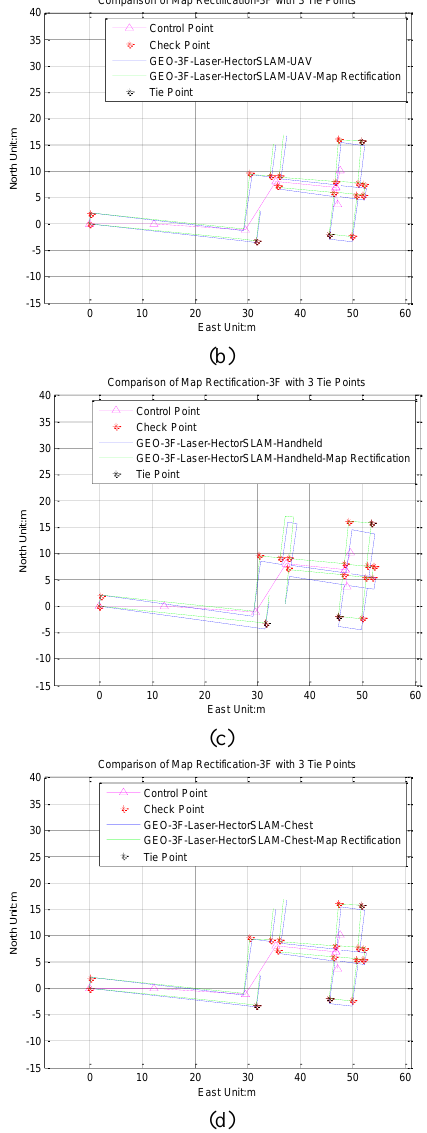
Comparison of Map Rectification-3F with 3 Tie Points Control Point Figure 8. The generated map using different platforms after map Check Point rectification. (a) shows the map using robot; (b) shows the map GEO-3F-Laser-HectorSLAM-Robot GEO-3F-Laser-HectorSLAM-Robot-Map Rectification using UAV; (c) shows the map using handheld approach and (c) Tie shows the map using chest package Figure 9 shows the error analysis in the bar chart, it is important that all error can be effectively controlled under 1 m using the proposed map rectification. From Table 1, the RMSE of each raw map is about 0.8 to 1.8 meters. The raw map using robot platform is better than other platforms. With map rectification, all RMSE and mean errors are under a meter and with the great improvement. The improvement of handheld approach, chest package, UAV and robot are 91%, 91%, 81% and 64%, respectively.